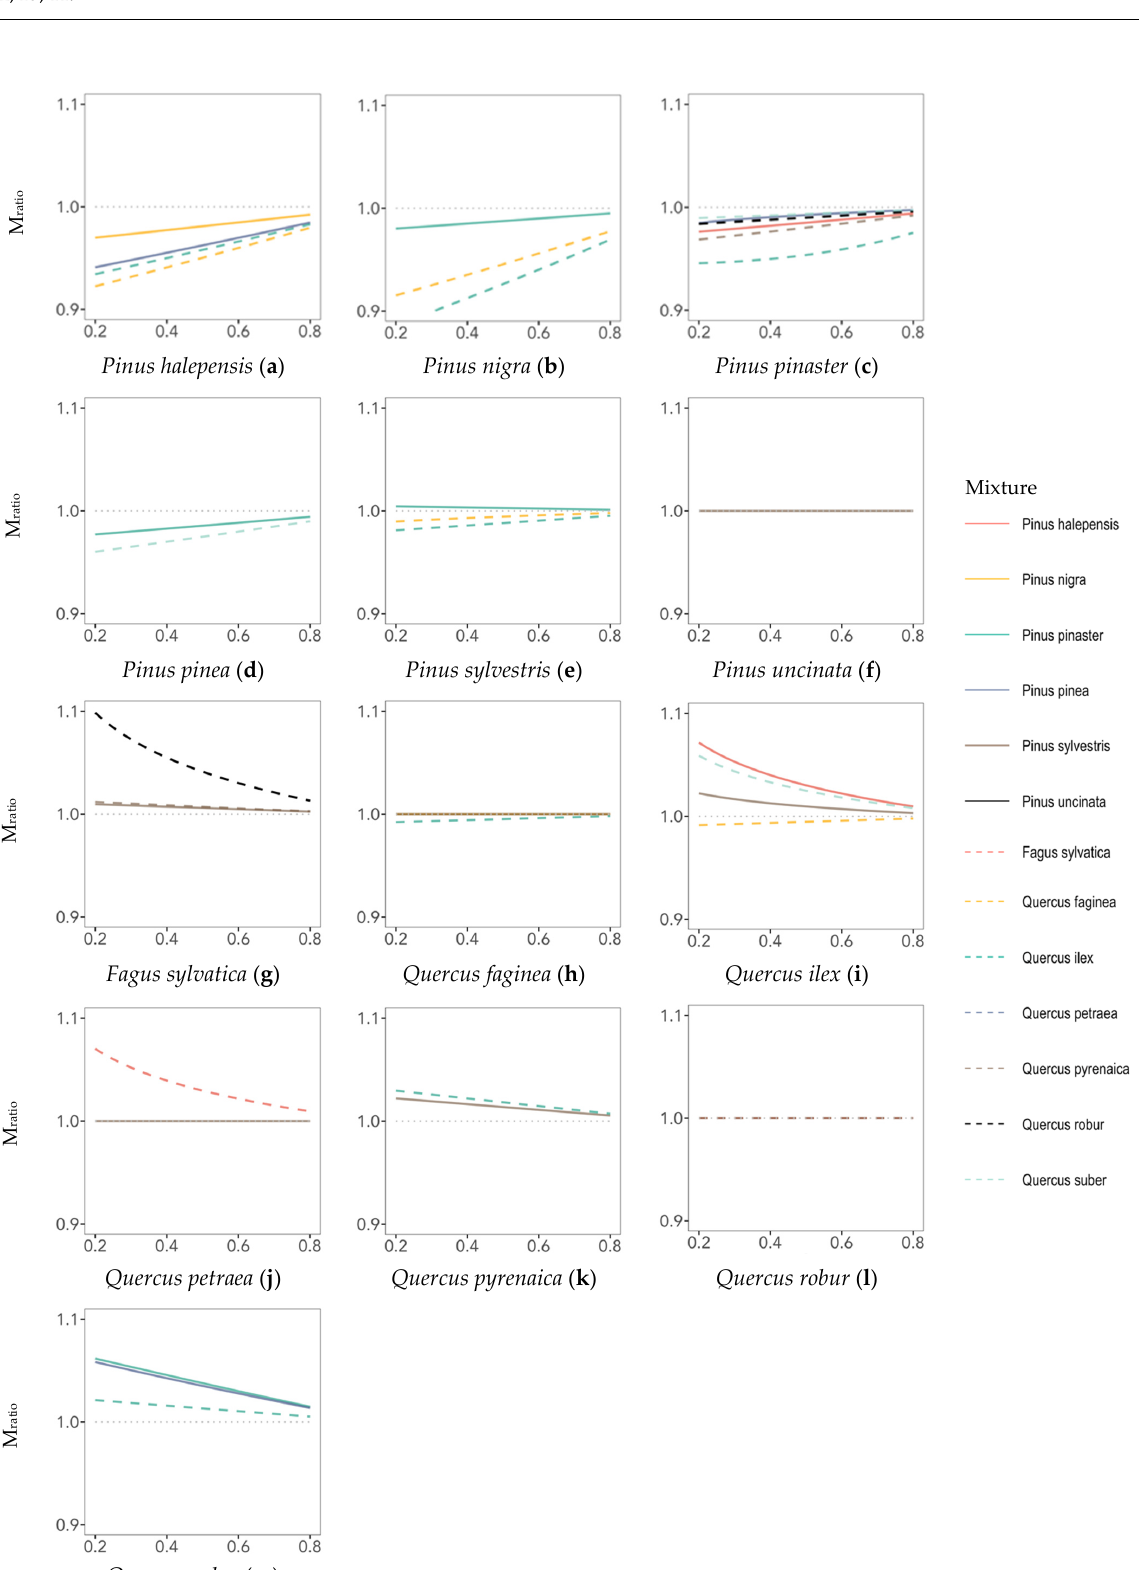
Figure 1. Variation of height under different species’ mixing proportions (m i – x -axis) based on the M (ratio) ( y -axis). Letters a-m indicate the species name in order to make reference to them along the text. Note: M (ratio) represents whether height in mixed forests is higher (M (ratio) > 1) or lower (M (ratio) < 1) than pure stands. All independent variables (excepting m i ) have been fixed to the mean of each